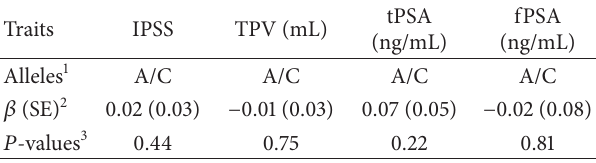
Table 3: Associations between rs2252004 and baseline clinical data.